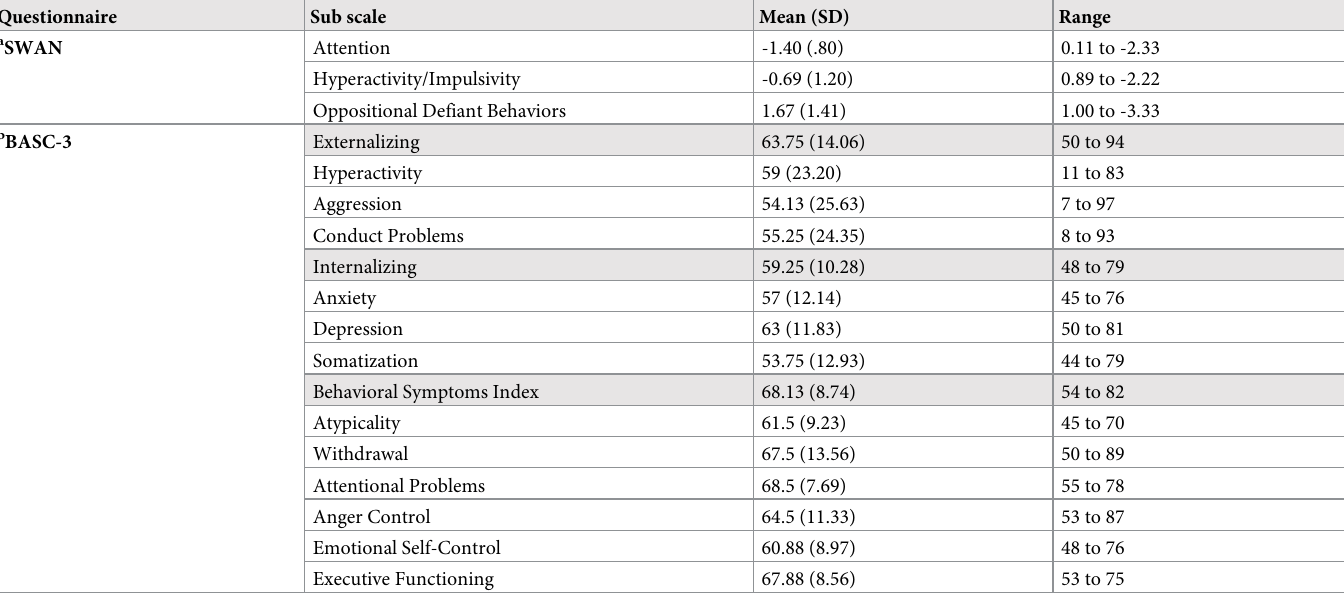
Table 1. Behavioral and emotional functioning: SWAN and BASC-3 PRS